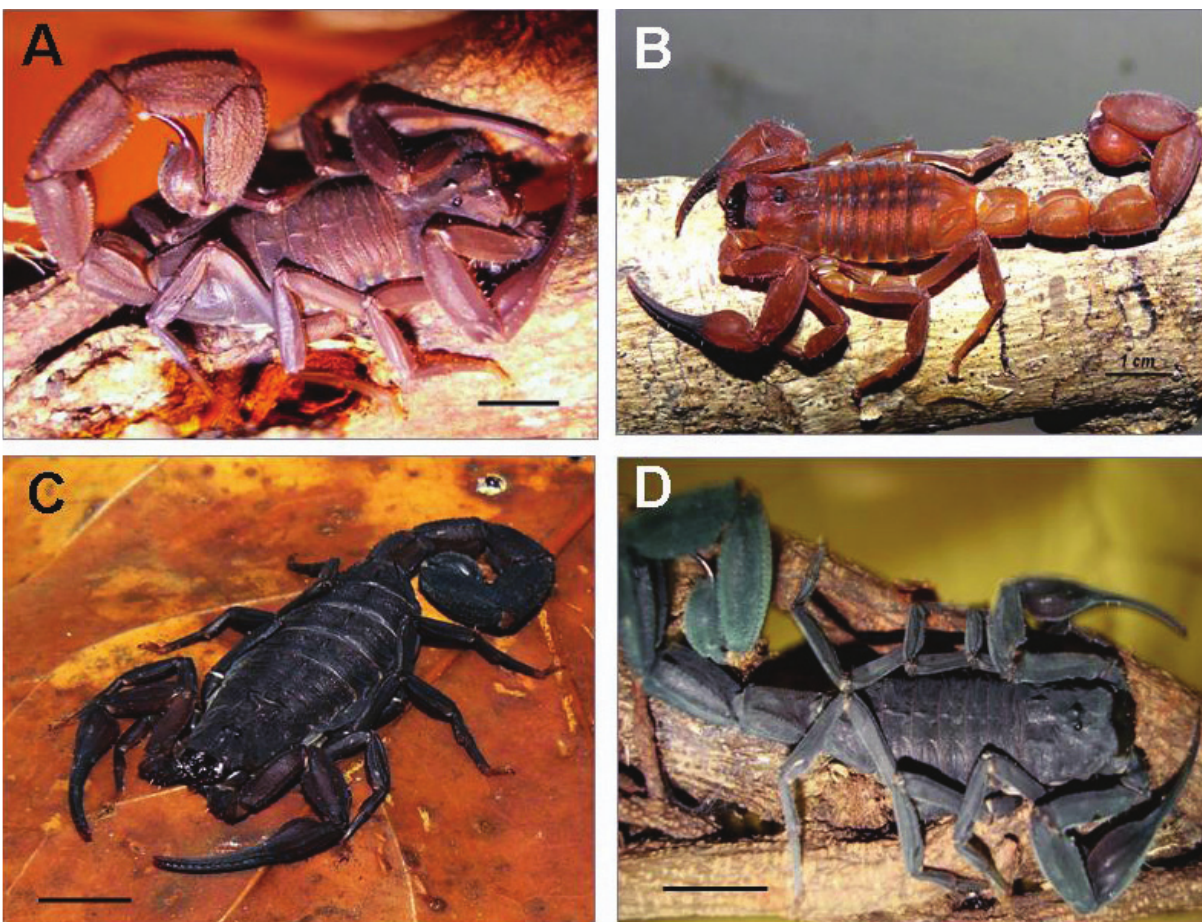
Figure 2. Species that belong to the genus Tityus responsible for severe scorpionism in Panama. ( A ) T. asthenes Pocock; ( B ) T. cerroazul Lourenço; ( C ) T. pachyurus Pocock; ( D ) T. festae Borelli ( A : picture by A. Borges; B-D : pictures by R. Miranda). Bars are equivalent to 1 cm of